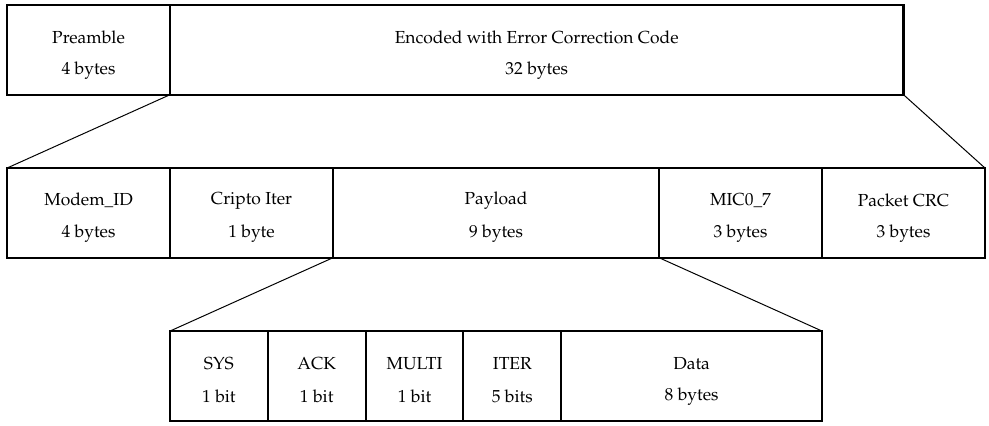
Figure 2. Uplink frame structure in